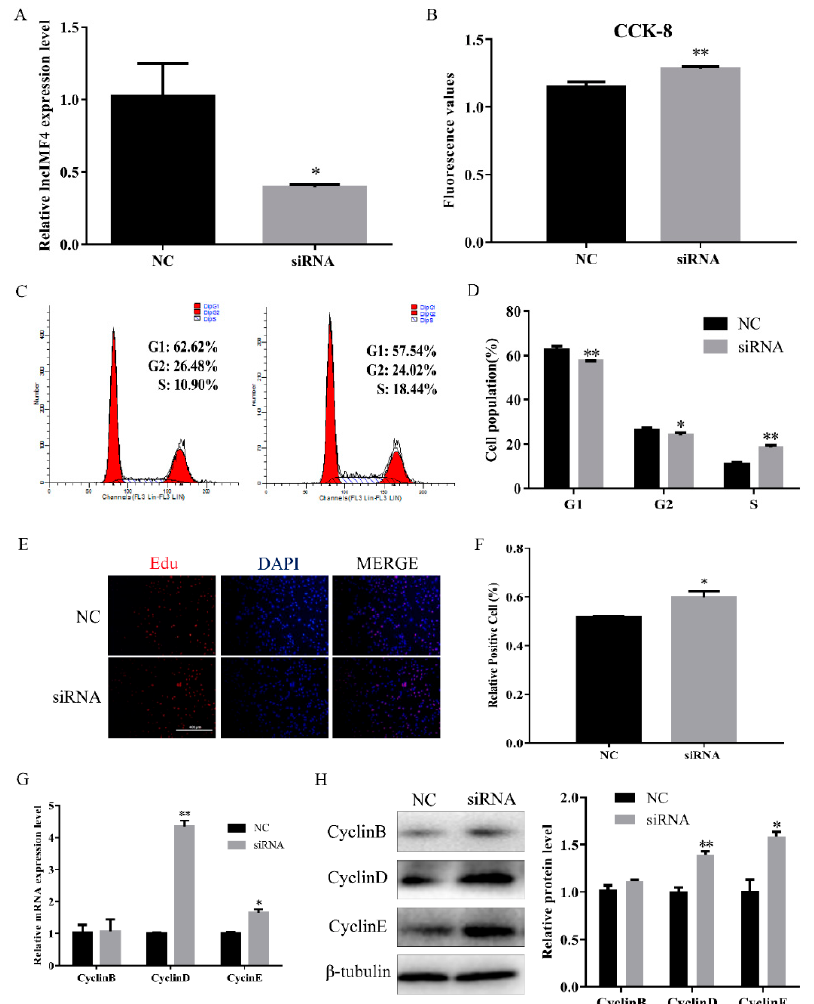
Figure 3. Knockdown of lncIMF4 promoted intramuscular adipocytes proliferation. LncIMF4 negative control (NC) or siRNA were transfected into cells at 40% density. ( A ) The inhibition e ffi ciency of lncIMF4 in porcine intramuscular adipocytes treated with lncIMF4 siRNA. ( B ) Cell count was measured by Cell Counting Kit 8 (CCK8). ( C ) Cell cycle analyses. ( D ) The statistics results of cell cycle